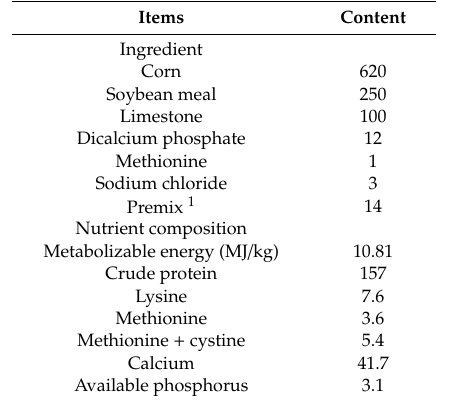
Table 1. Ingredient and nutrient composition of the basal diet (g / kg unless otherwise